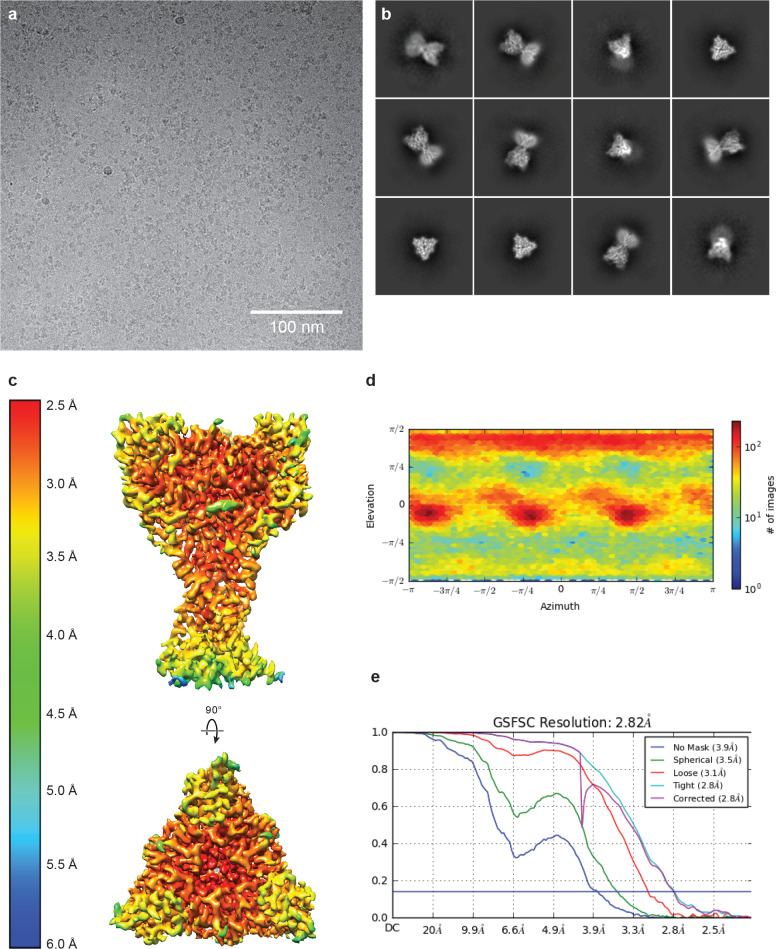
Cryo-EM of cASIC1-SMA at pH 7.0.(a-b) Representative micrograph (a) and 2D classes (b) of cASIC1-SMA at pH 7.0. (c–e) Local resolution estimation (c) angular distribution (d) and gold standard FSC resolution estimation (e) from final non-uniform refinement in cryoSPARC V2.